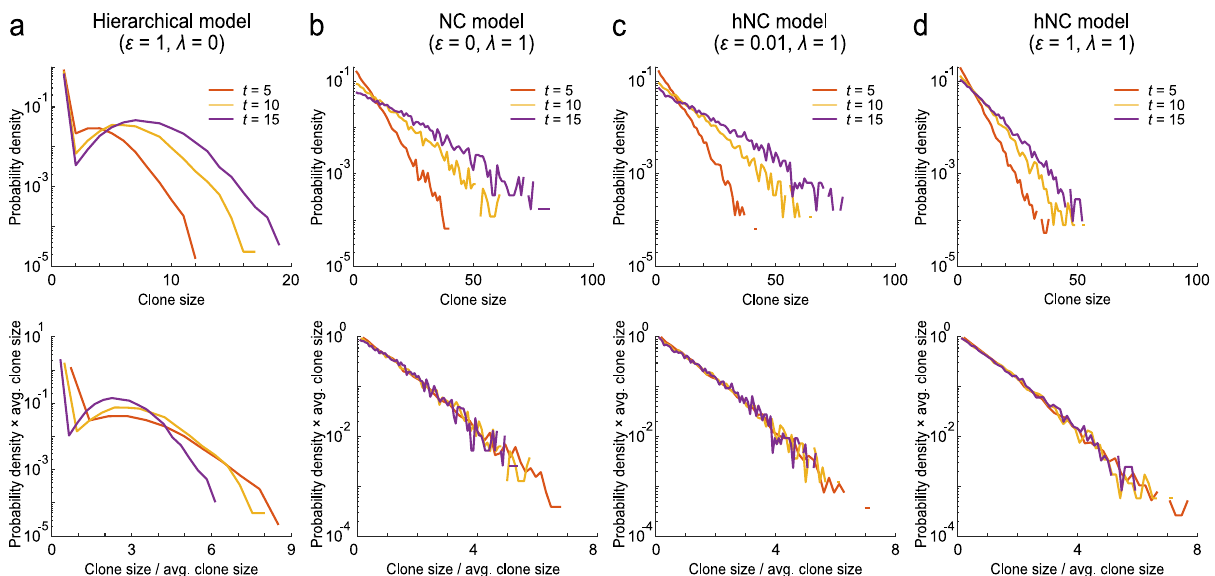
Fig. 4 Scaling law of clone size distribution in the NC and hNC models. Probability distribution of clone size calculated by the simulation mimicking the pulse-labeling experiment. Simulations were performed 100,000 times using 10 master stem cells and 100 competitive stem cells. Cells were randomly labeled from among the master and competitive stem cells. The clone size distributions of a labeled clone were plotted at different time points in the ( a ) hierarchical model, ( b ) NC model, and ( c , d ) hNC model with the two conditions. The upper and lower panels show the distributions before and after scaling by the average clone size at each time point, respectively, as equation